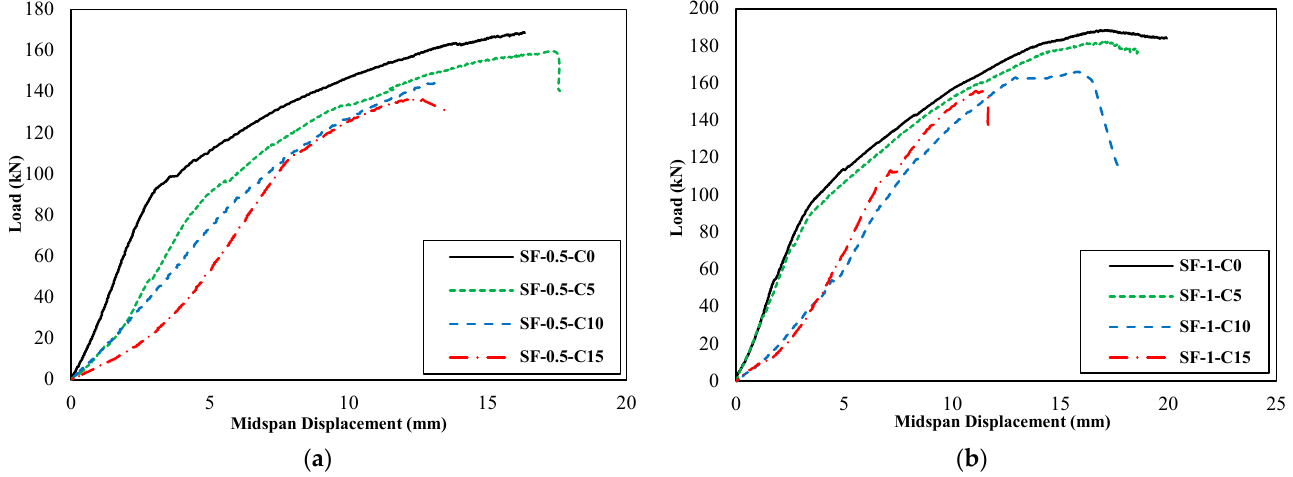
Figure 13. Load–midspan displacement diagrams: ( a ) specimens with a 0.5% volume fraction, ( b ) specimens with a 1.0% volume fraction.